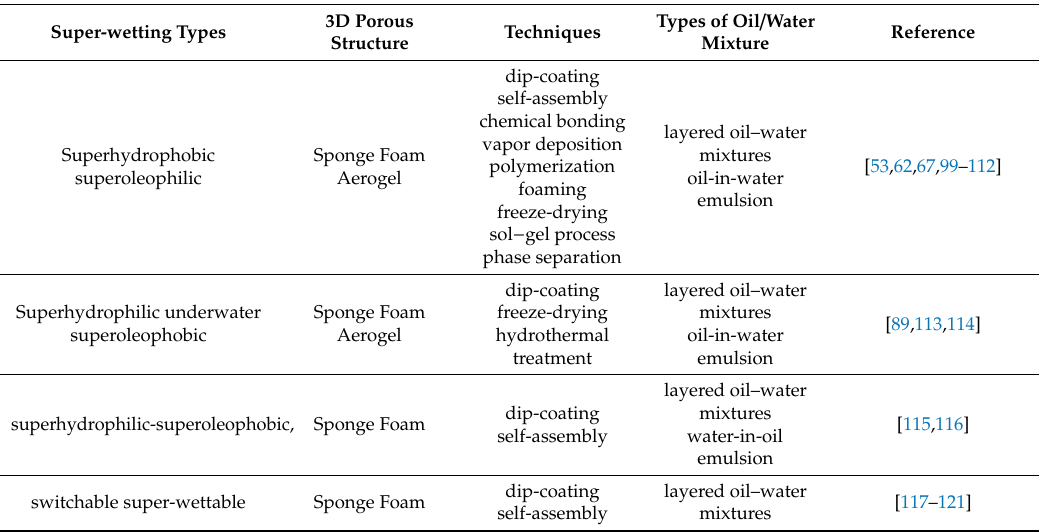
Table 1. The techniques reported to develop di ff erent super-wetting 3D porous materials and the treated specific type of oil / water